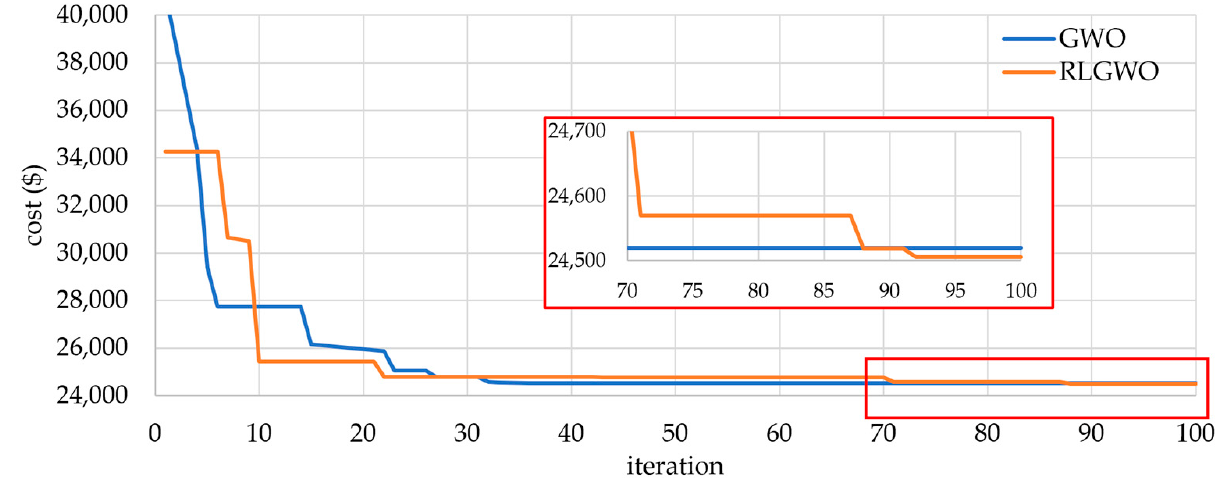
Figure 4. Comparative convergence characteristic of original GWO and proposed RLGWO algo ‐ rithm for the 13 ‐ unit system.